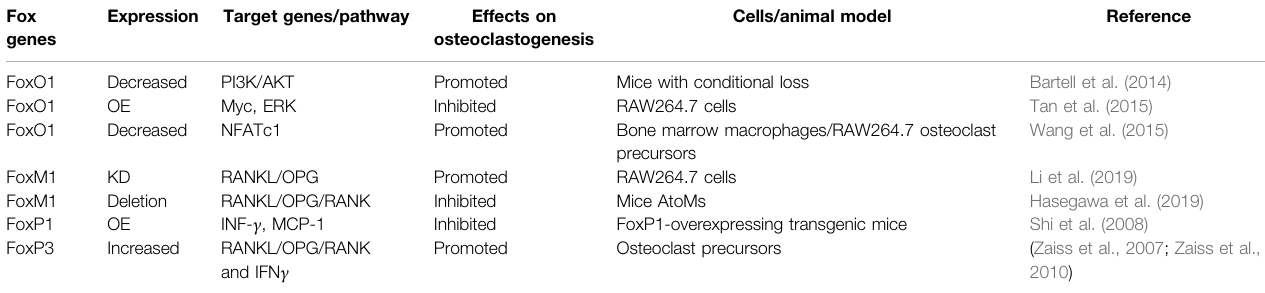
TABLE 2 | The role of the Fox subfamilies in osteoclast